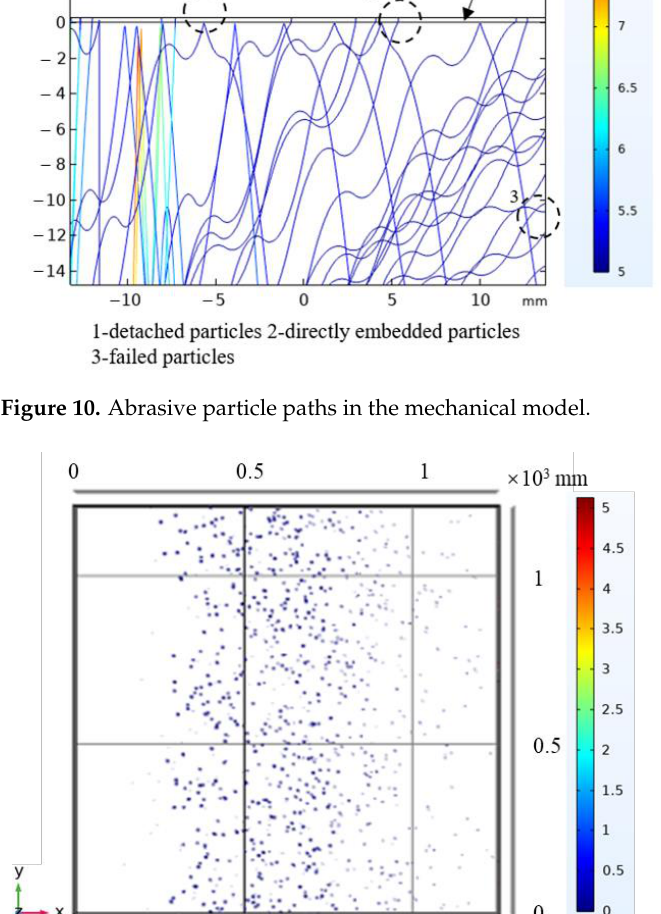
( b ) Figure 12. F lowchart of the numerical procedure: ( a ) mechanical model; ( b ) field model.